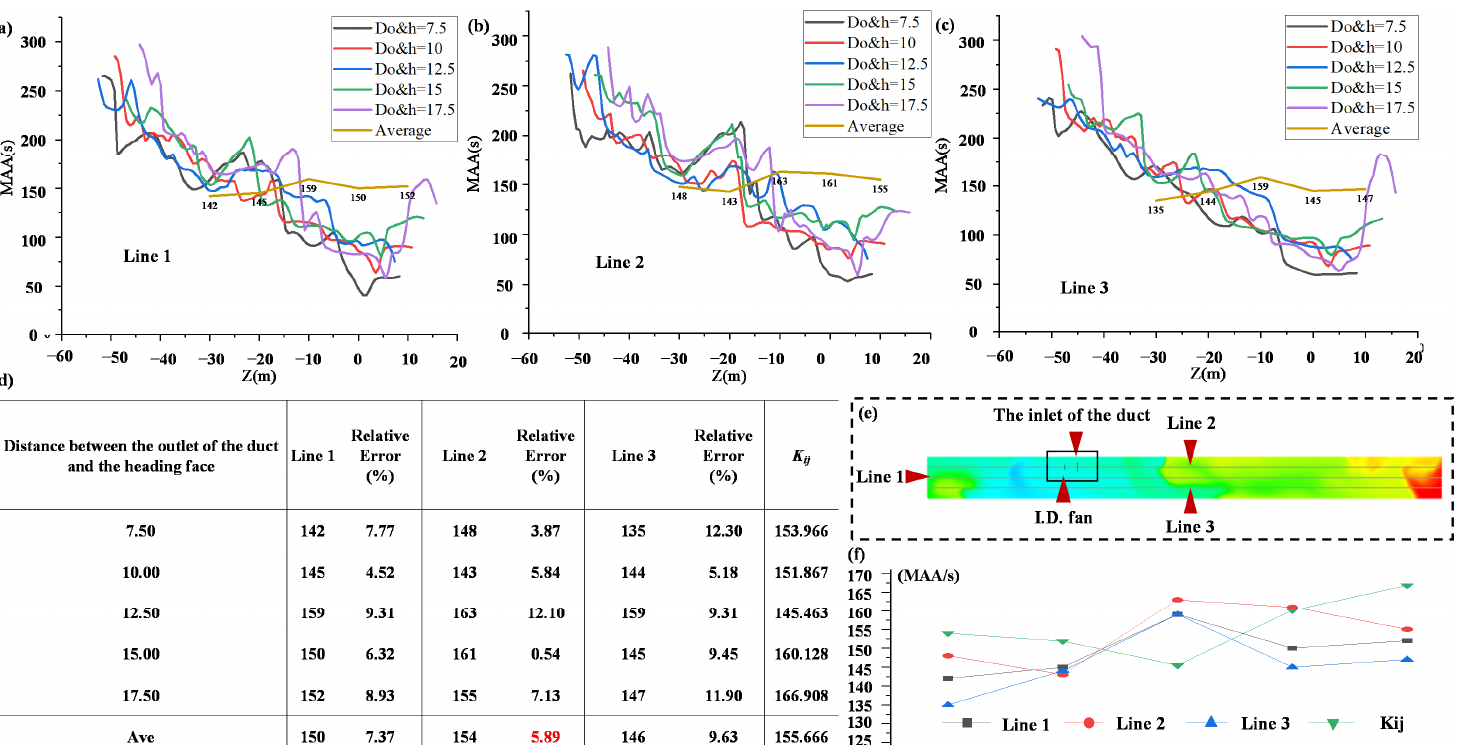
Figure 8. ( a ) The MAA on Line 1 when changing D o&h ; ( b ) The MAA on Line 2 when changing D o&h ; ( c ) The MAA on Line 3 when changing D o&h ; ( d ) The average MAA on each line when changing D o&h and comparing with average K ij ; ( e ) Three lines set in the breathing zone; ( f ) The curves of the average MAA on each line and average K ij .